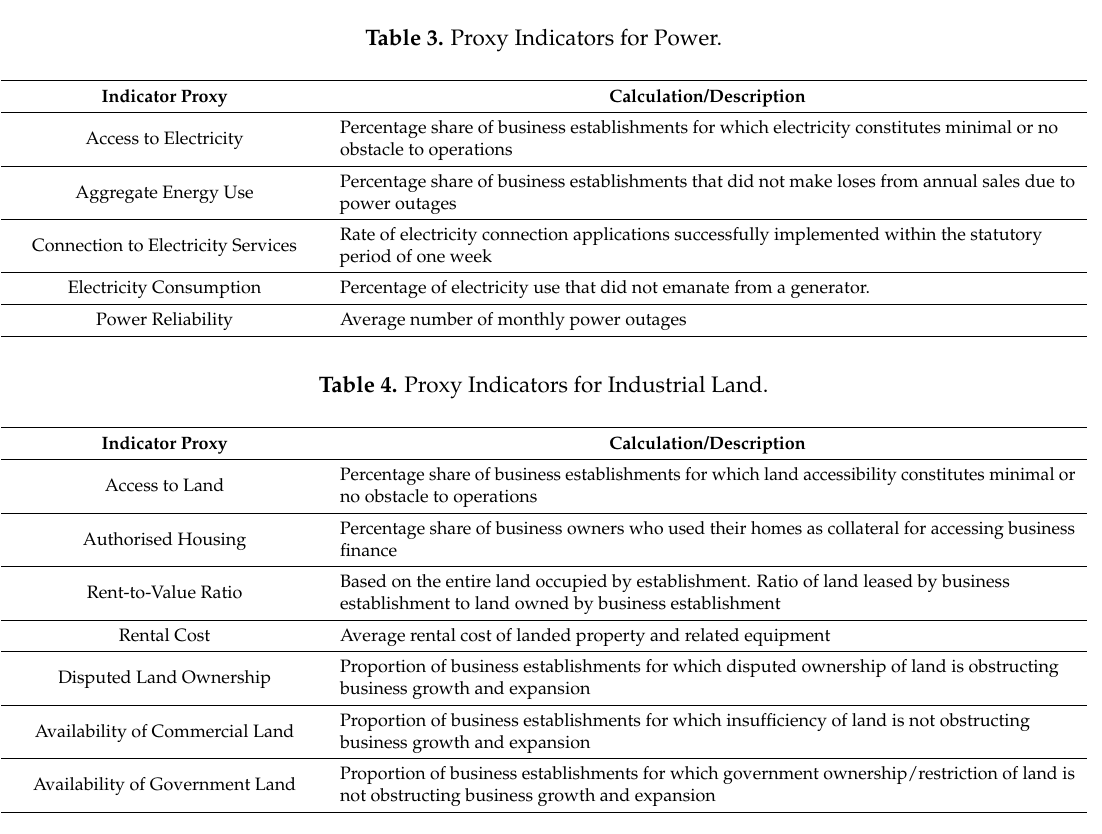
Table 5. Proxy Indicators for Information and Communication